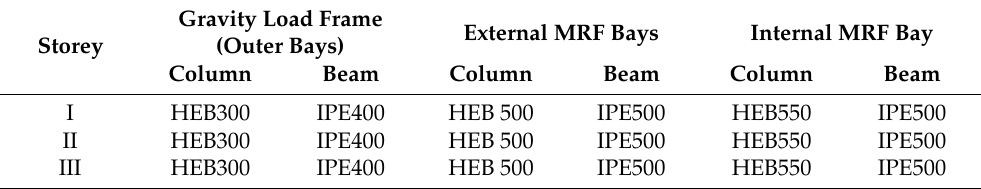
Table 1. Cross section of the investigated moment-resisting frame .